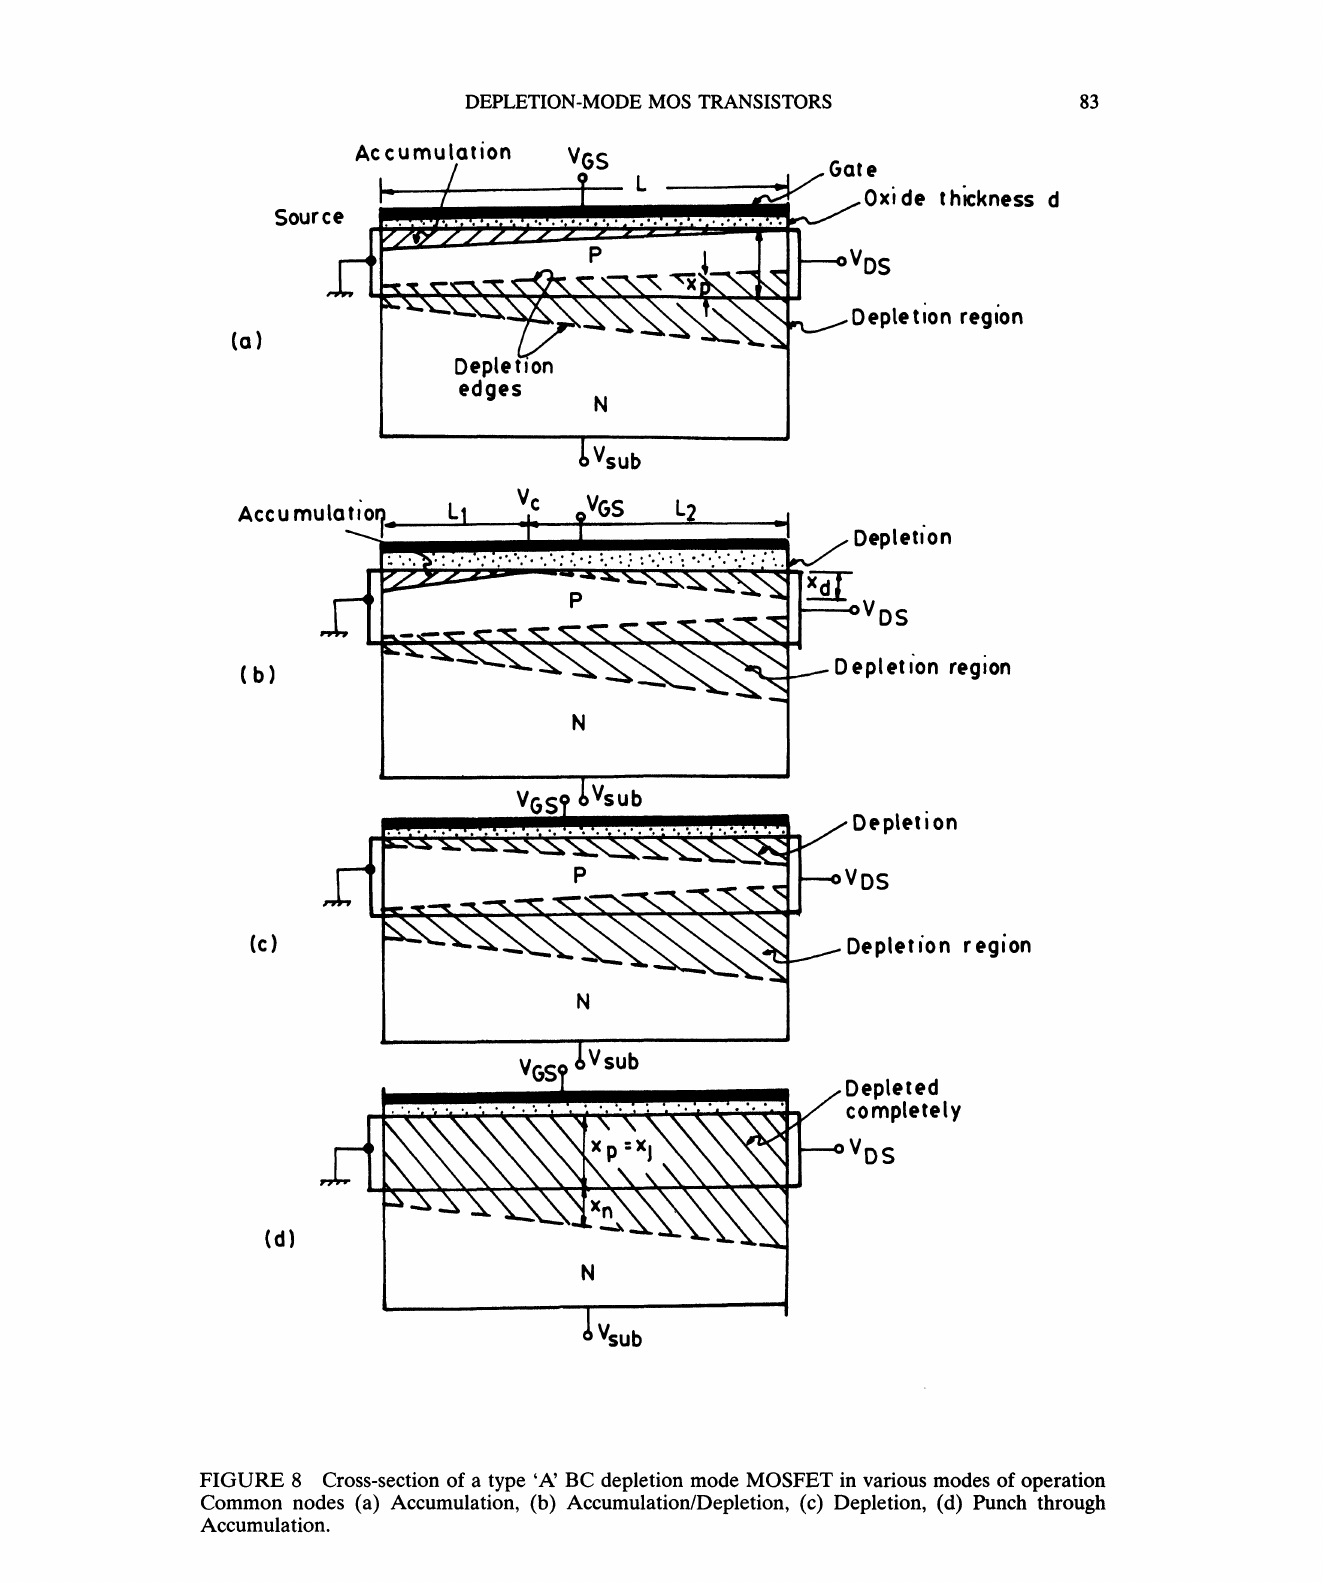
FIGURE 8 Cross-section of a type ’A’ BC depletion mode MOSFET in various modes of operation Common nodes (a) Accumulation, (b) Accumulation/Depletion, (c) Depletion, (d) Punch through